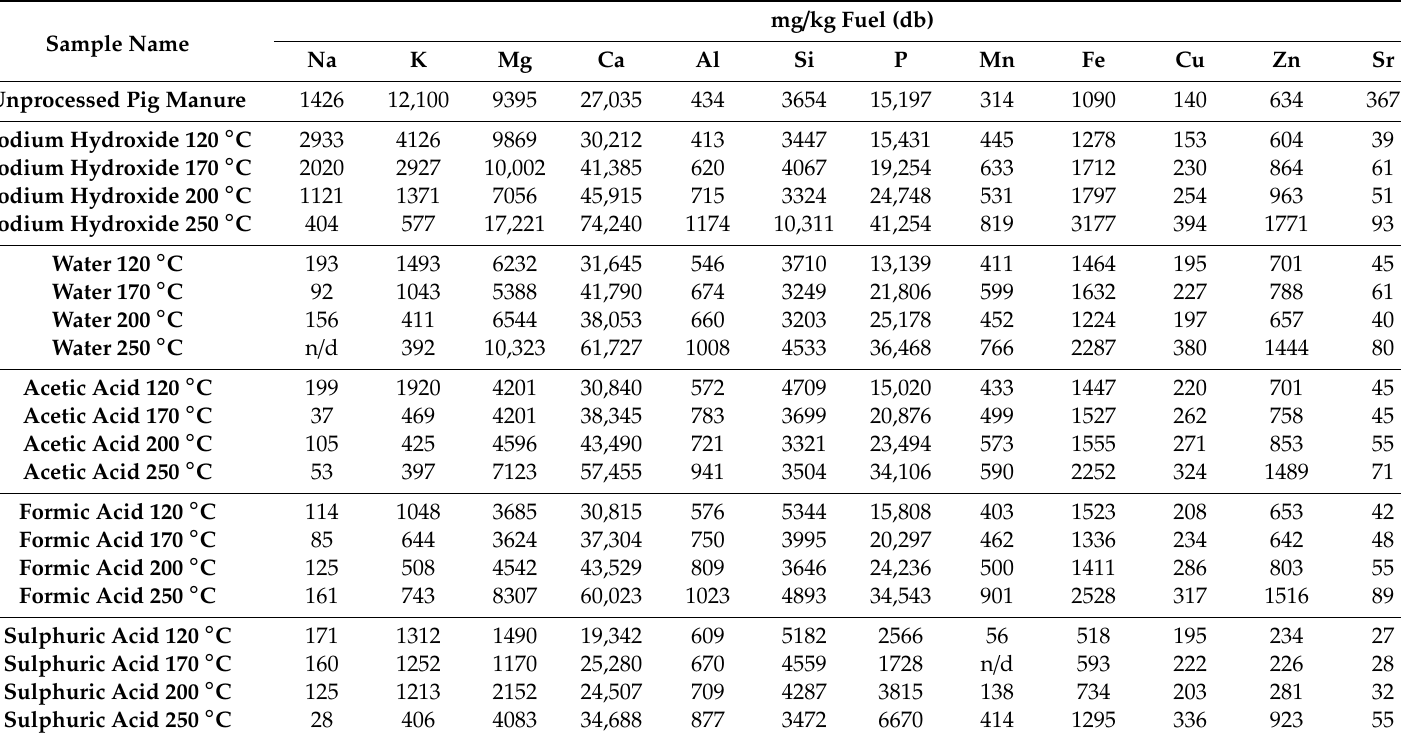
Table 4. Main inorganics present within the unprocessed pig manure and derived bio-coals; n / d—not